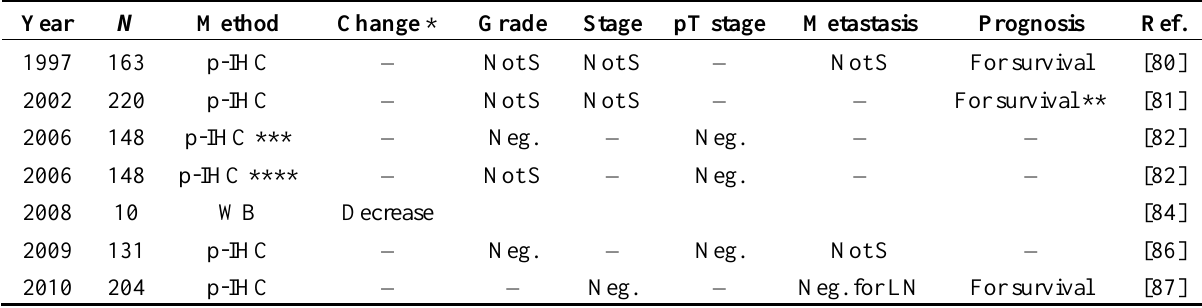
Table 3. Correlation between TSP-1 expression and clinicopathological features in patients with urothelial